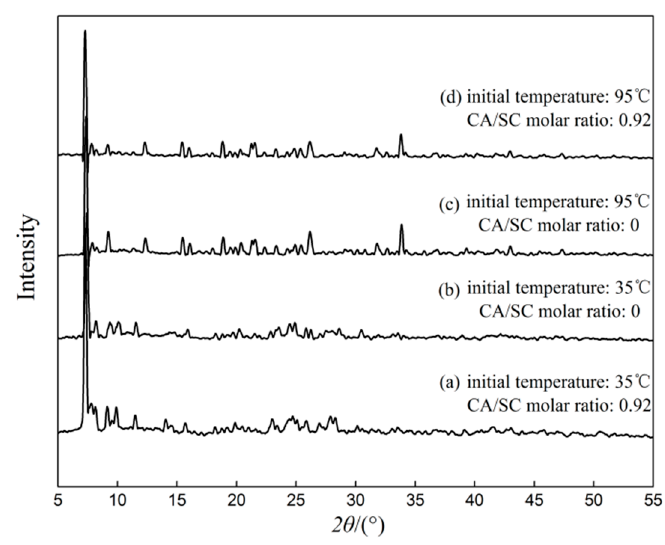
Figure 7. XRD patterns of lead citrate crystals obtained under different synthesis conditions.